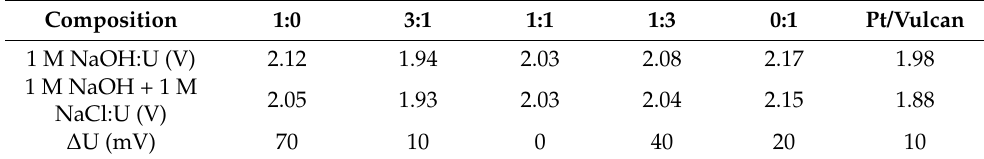
Table 2. Quantitative data from the electrolysis at different electrocatalysts (both at anode and cathode) for PANI-Ni:PANI-Co ratios of 1:0, 3:1, 1:1, 1:3, and 0:1 based on atomic ratio of Ni:Co after calcination. Required voltage to reach 80 mA (equivalent to 10 mA cm − 2